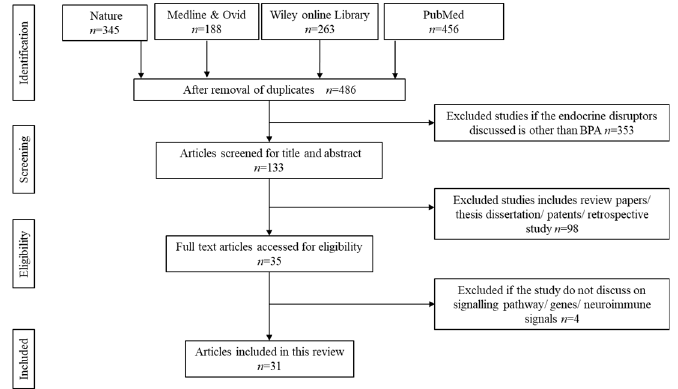
Figure 1. Identification and screening for literature search.